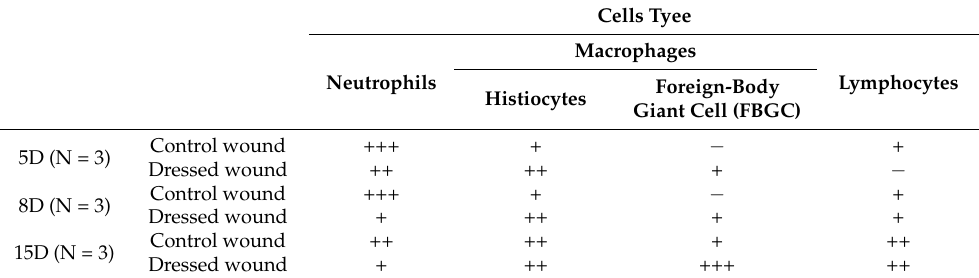
Table 3. Differences in cell types detected in tissues derived from the control and dressed full- thickness surgical skin wounds in male C57BL/6J mice.